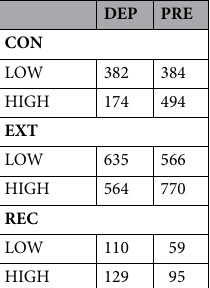
Table 2. Mean numbers of AL patches in individual categories of persistence.